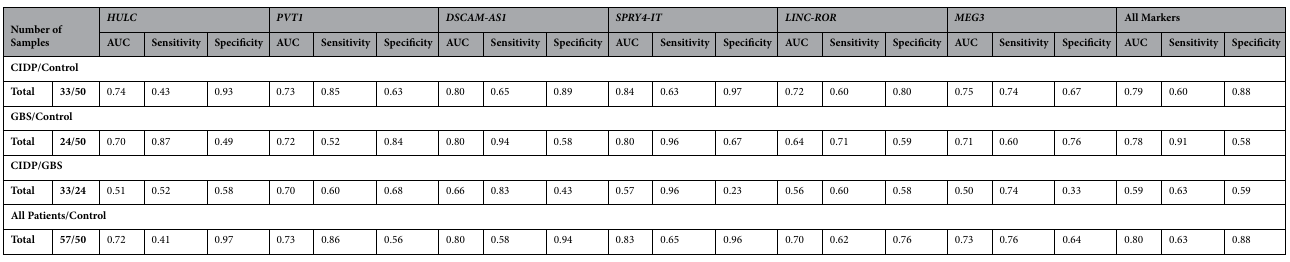
Table 4. Detailed parameters of depicted ROC